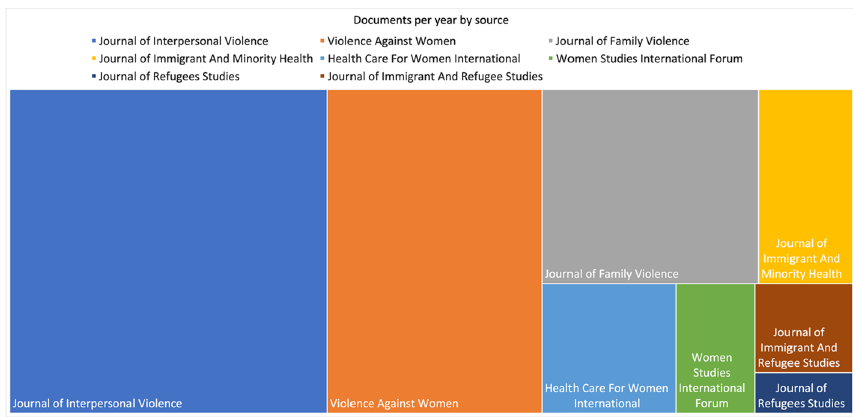
Fig. 3 Total number of published documents by source—years